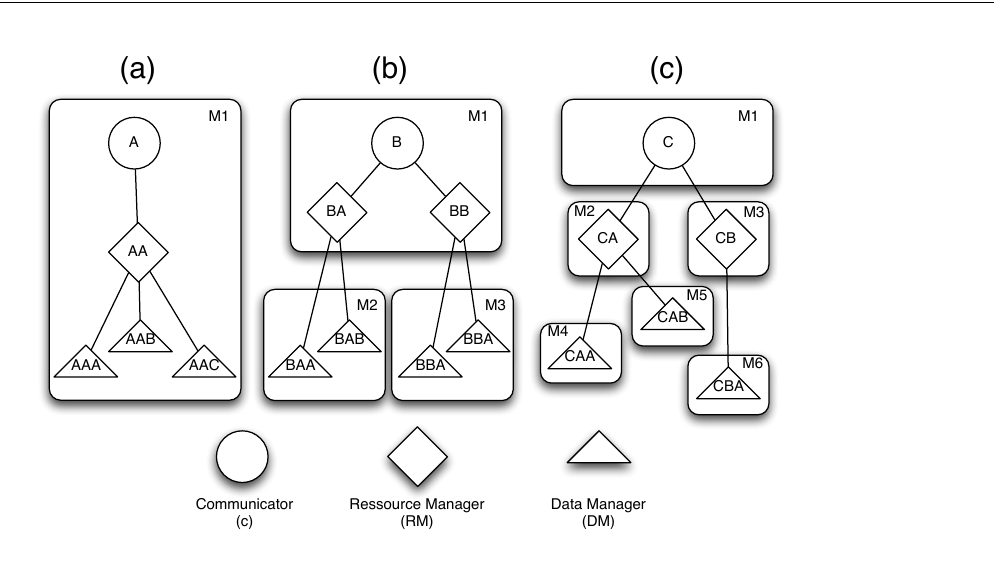
Figure 2. Organization of the nodes in a machine (a), in a cluster (b) and in a network (c)